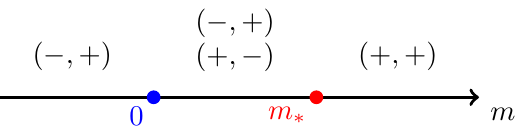
Figure 3. Phase diagram for ω = 0 . At m = 0 there is a wall across which the Witten index jumps, while at m = m there is a second-order phase ∗